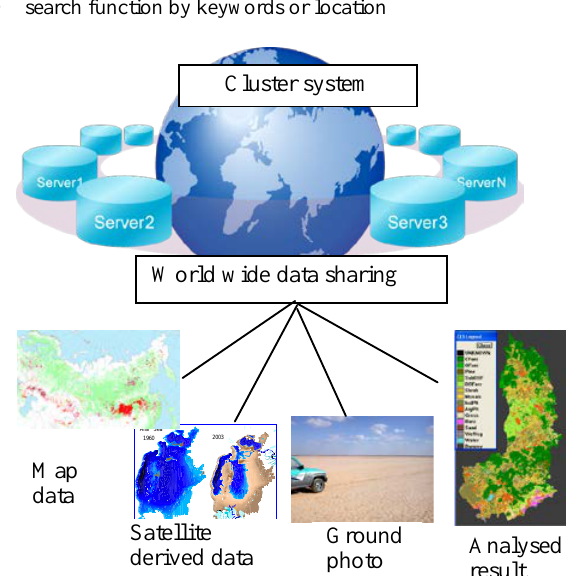
Figure 1 A new geospatial data sharing system, CEReS